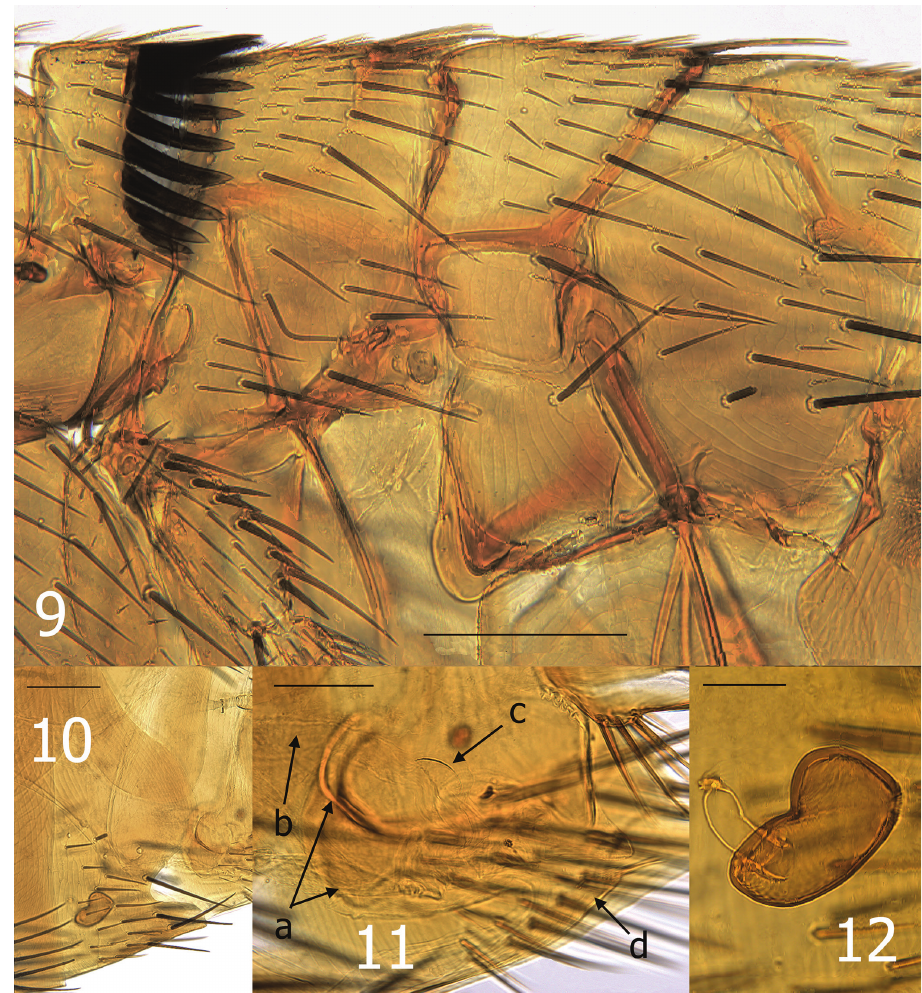
Figures 9–12. Medwayella independencia , sp. n. 9 Thorax, holotype male (P-5525) 10 Seventh sternum, female paratype (P-5657) 11 Vaginal canal, female allotype, a = mesal tanned ridge of T-VIII, b = dilated portion of duct of spermatheca, c = sclerotized ventral wall of perula, d = eighth sternum 12 Spermatheca, female allotype. (Scale: 9–10 = 200 µm, 11 = 100 µm, 12 = 50 µm).